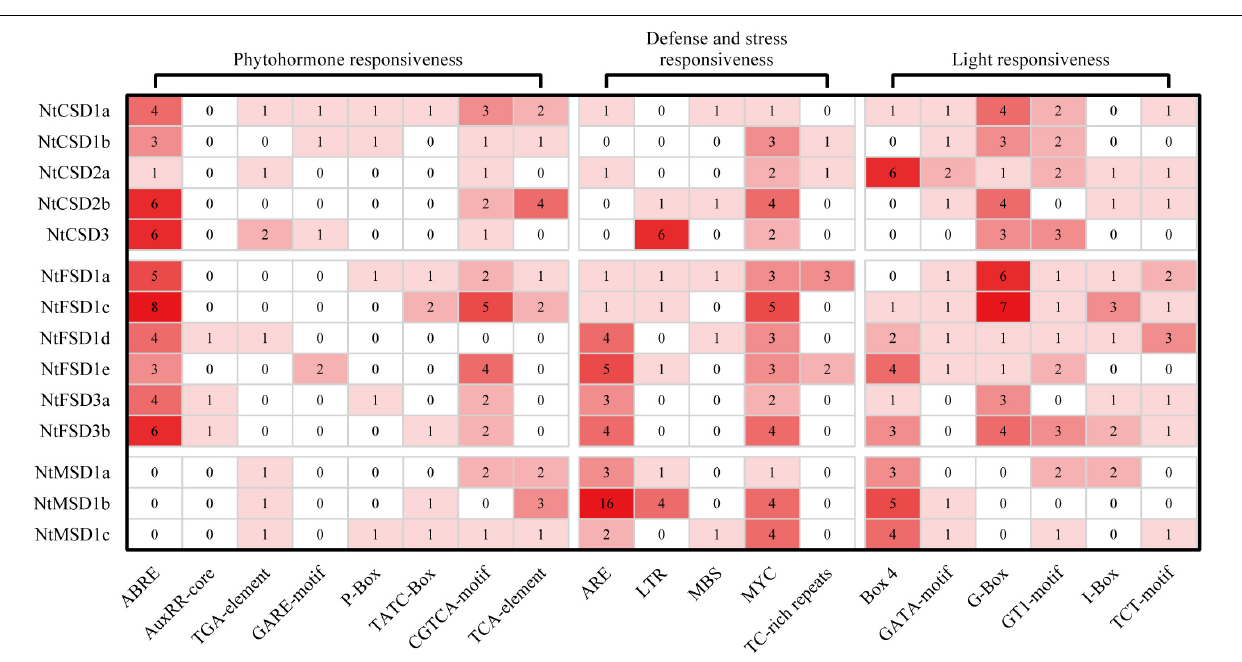
FIGURE 4 | Cis -acting elements in the promoters of NtSOD genes. The frequencies of cis -acting elements are represented by numbers and different colors of